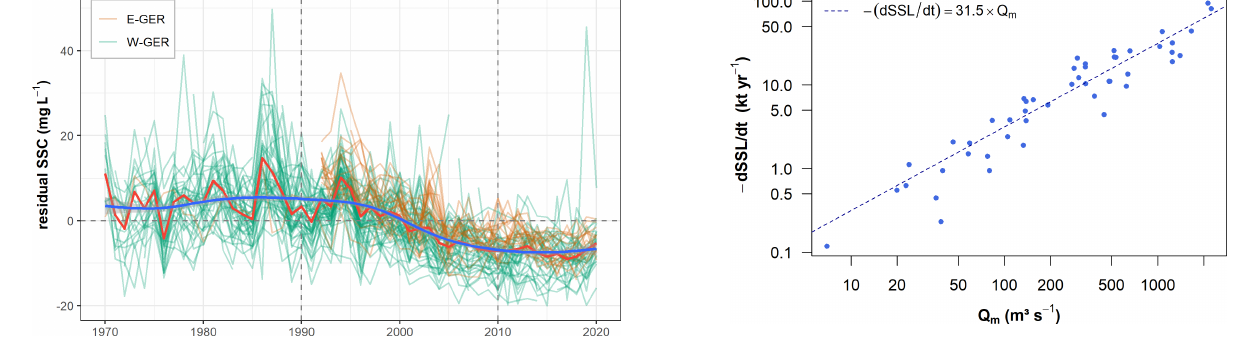
Figure 7. Trends of residual SSC between 1970 and 2020. SSC residuals are calculated based on daily SSC data and the average SSC of all available SSCs covering the full monitoring length for each station. Light red lines indicate the annual average of SSC residuals for each station. The bold red line represents the aver- age annual SSC residual of all stations. The blue line represents a smooth spline of the average annual SSC residuals.